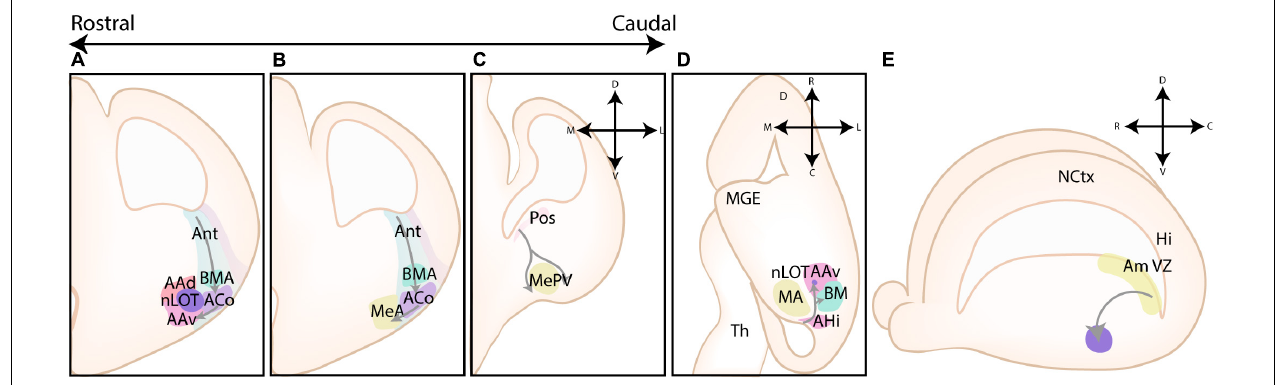
FIGURE 10 | Overview of several migratory routes toward pallial amygdalar nuclei. (A,B) Rostrocaudal gradient of schematic radial sections showing the radial translocation of anterior pallial amygdalar unit cells toward its derivatives. Cells from the anterior pallial amygdalar unit, marked by expression of Lhx9, experience massive translocation that completely depletes the periventricular stratum of cells. Migrating cells colonize the anterior basomedial amygdala (BMA) and the anterior cortical amygdala (ACo). From here, cells tangentially invade the anterior amygdala (AA) and the anterior and posteroventral part of the medial amygdala (MeA, MePV, resp.). (C) Schematic radial section highlighting the position of the posterior amygdalar unit and the caudoventral pallial (CVP)-derived migratory stream. The origin of this migratory stream seems to be located in the posterior amygdalar unit. This migratory stream splits into two streams that course ventrally to surround the MePV. (D) Schematic horizontal section showing the first phase (rostralwards) of the nLOT2 migratory stream (nLOT2ms). Cells originating in the rostromedial part of the amygdalo-hippocampal interface (AHi) course rostrally past the BMA toward the AA. A small stream of cells diverges from the nLOT2ms and seems to invade a medial shell surrounding the BMA. Within the AA, the migration continues ventralwards toward the nLOT2 (not shown). This migratory stream includes posterior pallial amygdalar cells and hypothalamic-derived cells, the migration route of the latter toward the AHi is shown in Figures 11A,B . (E) A side view of the developing murine brain, showing the lateral ventricle, the amygdalar ventricular zone (Am Vz) at the level of the posterior amygdalar pallium and the nLOT2 migratory stream (nLOT2ms). Cells originating from this amygdalar radial unit first migrate rostrally, independent from glial fibers, followed by a radial ventral migration toward the nLOT2 (purple). Nctx, Neocortex; Hi, hippocampus; AAd, dorsal part of anterior amygdala; AAv, ventral part of anterior amygdala; ACo, anterior cortical amygdala; AHi, amygdalo-hippocampal interface; BM, Basomedial amygdala MA, medial amygdala; MeA, anterior part of medial amygdala; MePV, posteroventral part of medial amygdala; nLOT2, layer two of nucleus of lateral olfactory tract; Pos, posterior amygdalar pallial unit; Th,